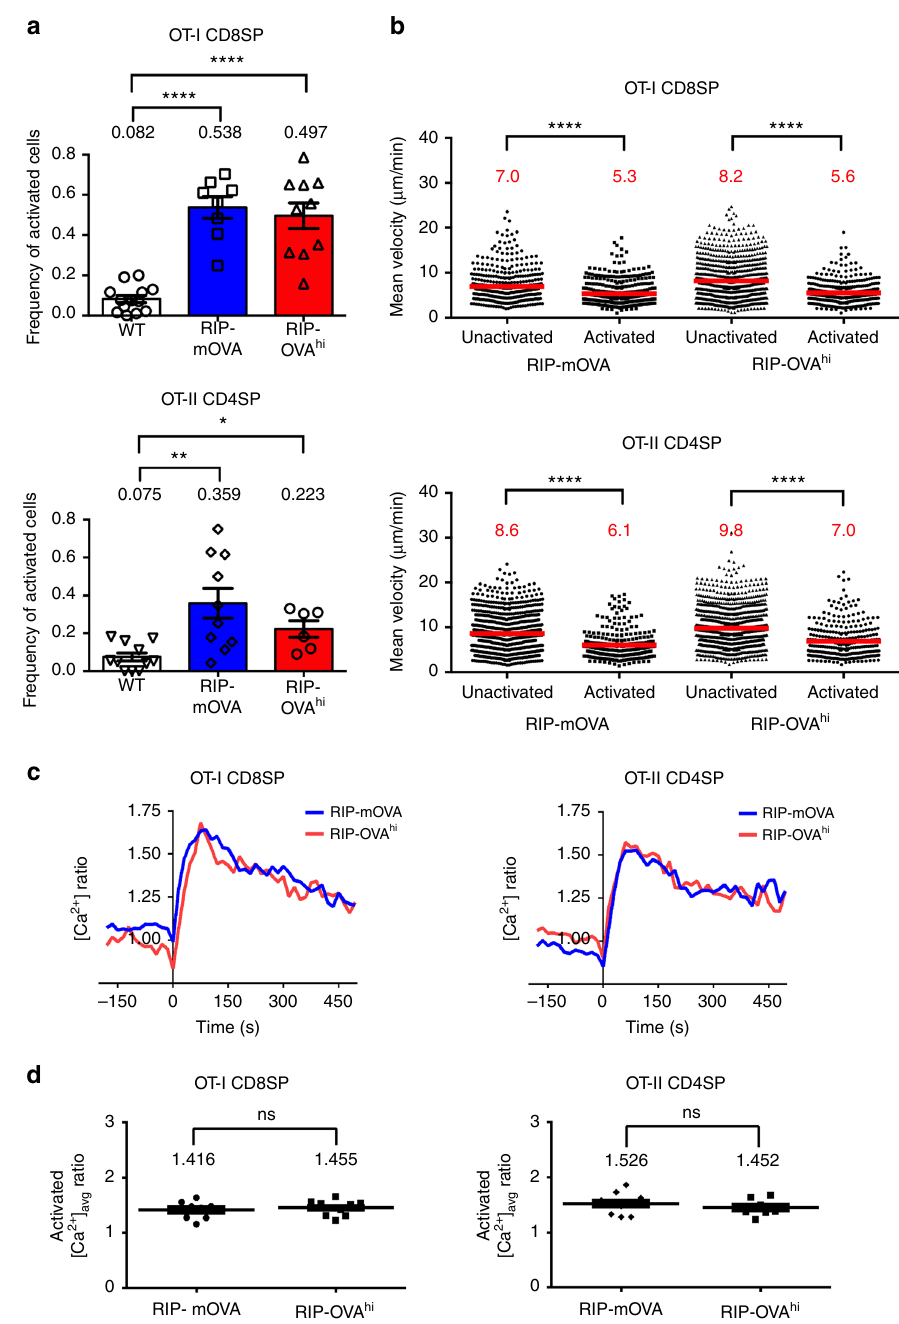
Fig. 2 The frequency of activation, but not the magnitude of calcium fl ux, differs for OT-I versus OT-II thymocytes responding to distinct model TRAs. a Frequencies of OT-I CD8SP and OT-II CD4SP thymocytes activated in WT (white), RIP-mOVA (blue), or RIP-OVA hi (red) thymic slices. Data points represent the average of all cells in an individual experiment, and bars represent mean ± standard error of the mean (SEM). b Individual mean cell velocities of unactivated and activated OT-I CD8SPs and OT-II CD4SPs migrating on RIP-mOVA or RIP-OVA hi thymic slices. Data points represent individual cells in all experiments, and red bars and numbers show mean values. c Average [Ca 2 + ] i levels of OT-I CD8SPs and OT-II CD4SPs undergoing initial activation on RIP-mOVA (blue; N OT-I = 35, N OT-II = 23) or RIP-OVA hi (red; N OT-I = 19, N OT-II = 18) thymic slices were quanti fi ed and traced across imaging experiments. Single-cell calcium traces were aligned with the lowest ratio value before fl ux (as de fi ned in the Methods section) set at time point 0. d The average calcium ratios of all activated OT-I CD8SPs and OT-II CD4SPs on RIP-mOVA or RIP-OVA hi thymic slices were quanti fi ed. Data points represent the average of all cells in an experiment, and bars and whiskers represent mean ± SEM. Data are compiled from 3 to 6 separate imaging experiments per condition. Analyzed by unpaired t tests, p -values: * < 0.05, ** < 0.01, **** < 0.0001. ns not signi fi cant. Source data are provided as a Source Data fi le. See also Supplementary Fig.